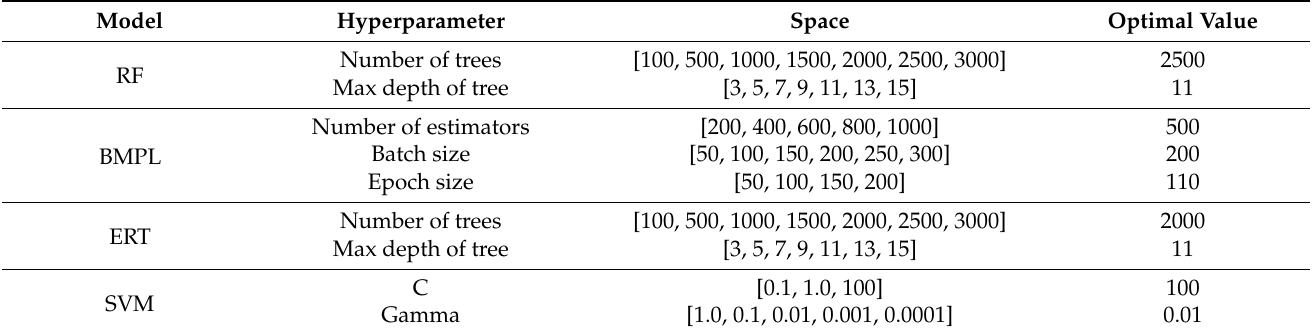
Figure 7. Pearson’s correlation matrix of the explanatory factors. Table 6. Optimal hyperparameter values of the